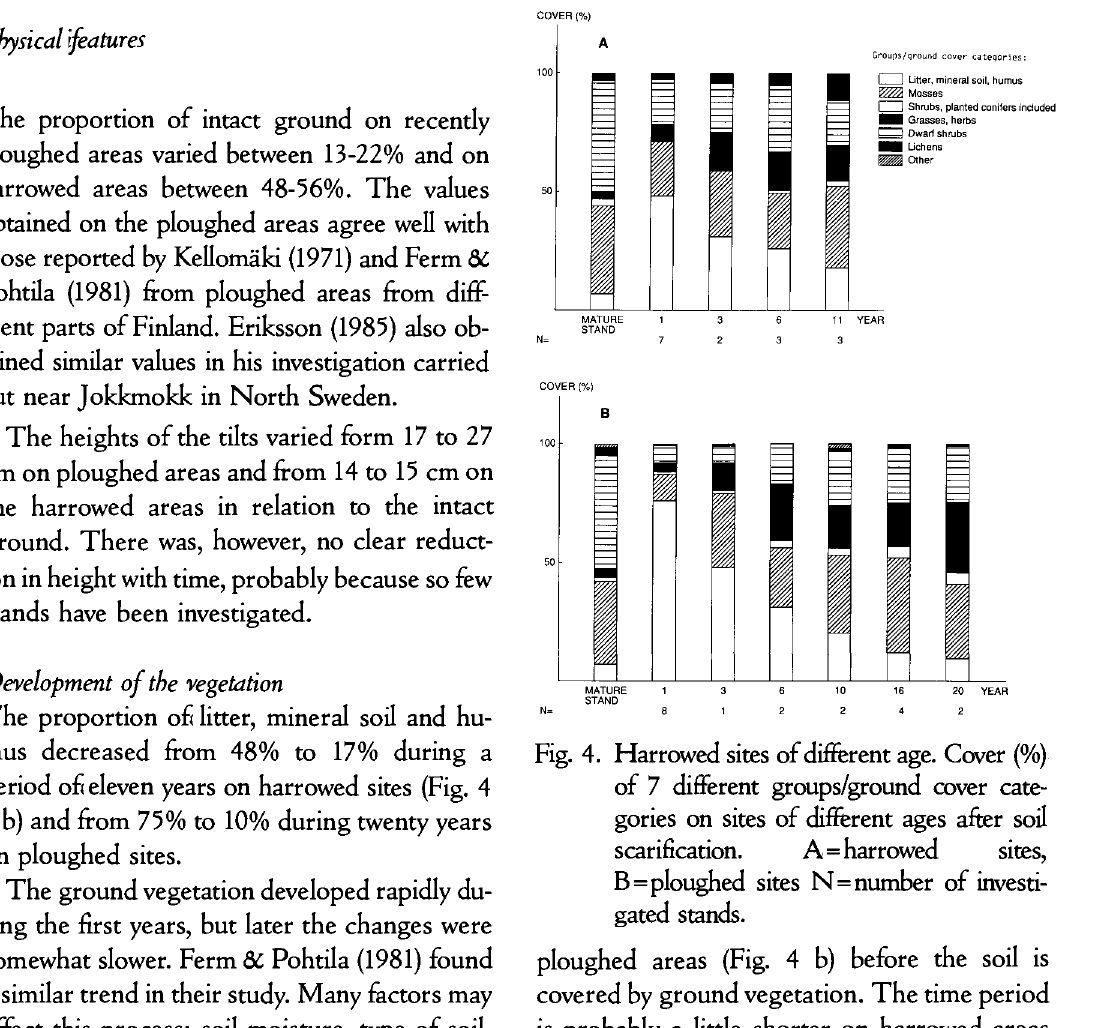
Fig. 4. Harrowed sites of different age. Cover (%) of 7 different groups/ground cover cate gories on sites of different ages after soil scarification. A = harrowed sites, B=ploughed sites N=number of investi gated